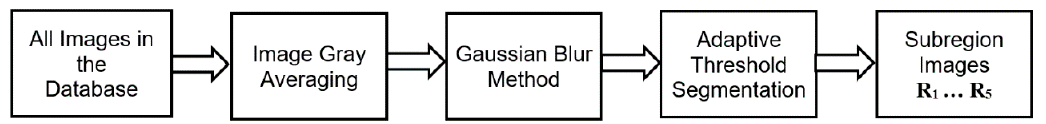
Figure 2. Steps of Image Preprocessing.